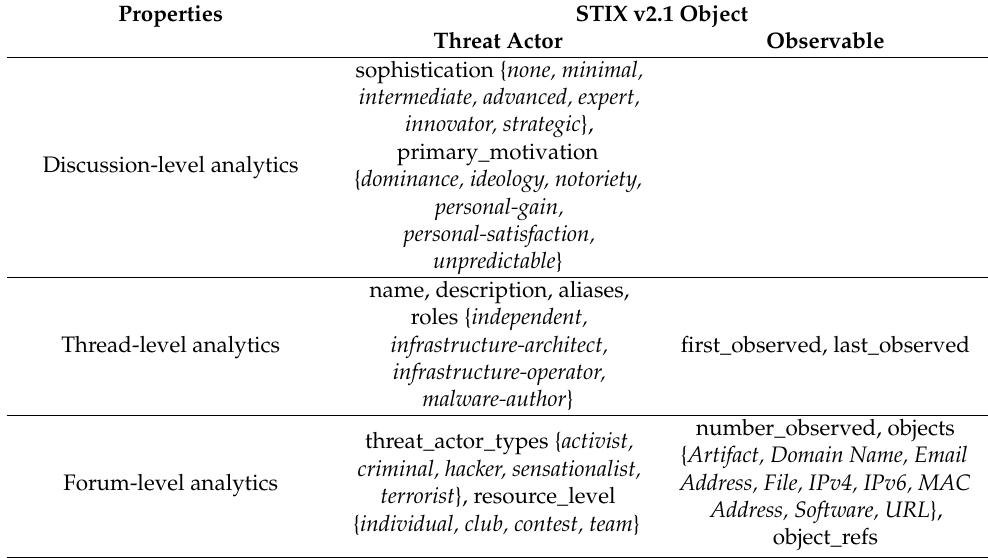
Table 7. DFA-Specific STIX v2.1 Objects.